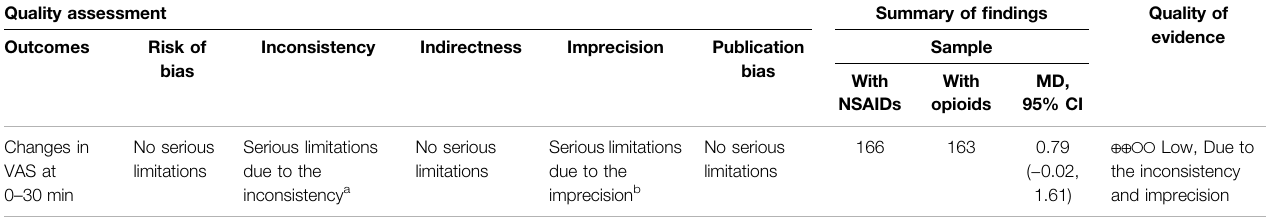
TABLE 2 | GRADE pro fi le of changes in VAS at 0 – 30